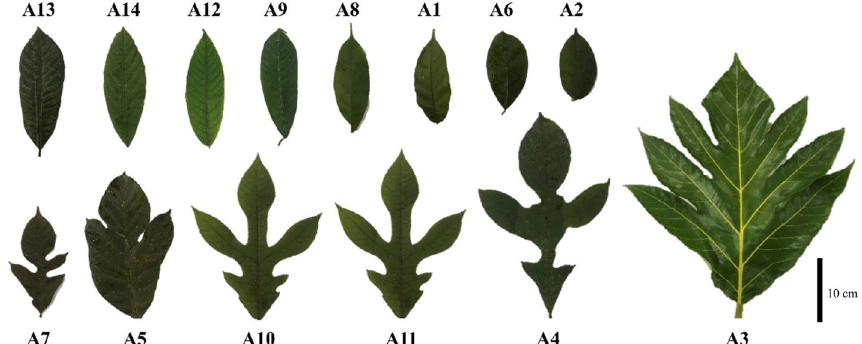
Fig. 2 Leaf morphology of endemic breadfruit ( Artocarpus spp.) from South Borneo, Indonesia, shows two different forms, i.e., narrow-obovate to